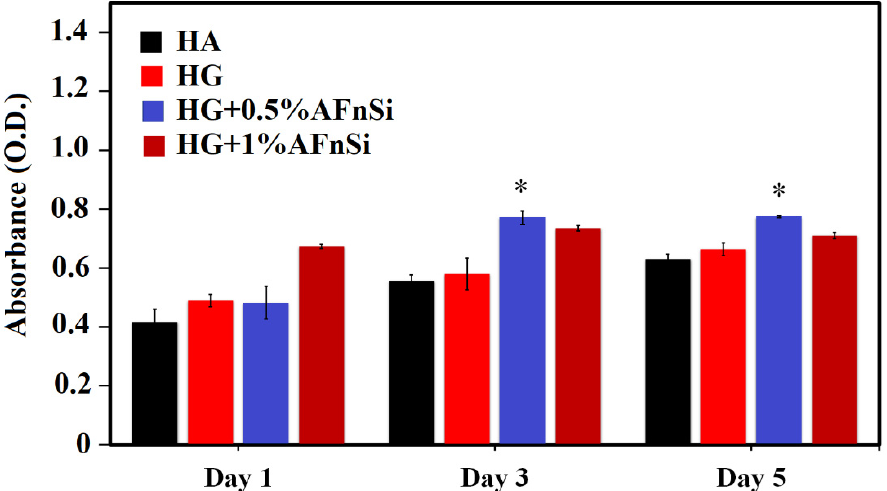
Figure 10. The cell viability evaluation by MTS assay in hADSCs were cultured with the photocured hybrid hydrogel of HG, HG+0.5% AFnSi, and HG+1% AFnSi. Only the HA was controlled. Error bar represents ± SD ( n = 3); * p < 0.05 compared with HA group, respectively.